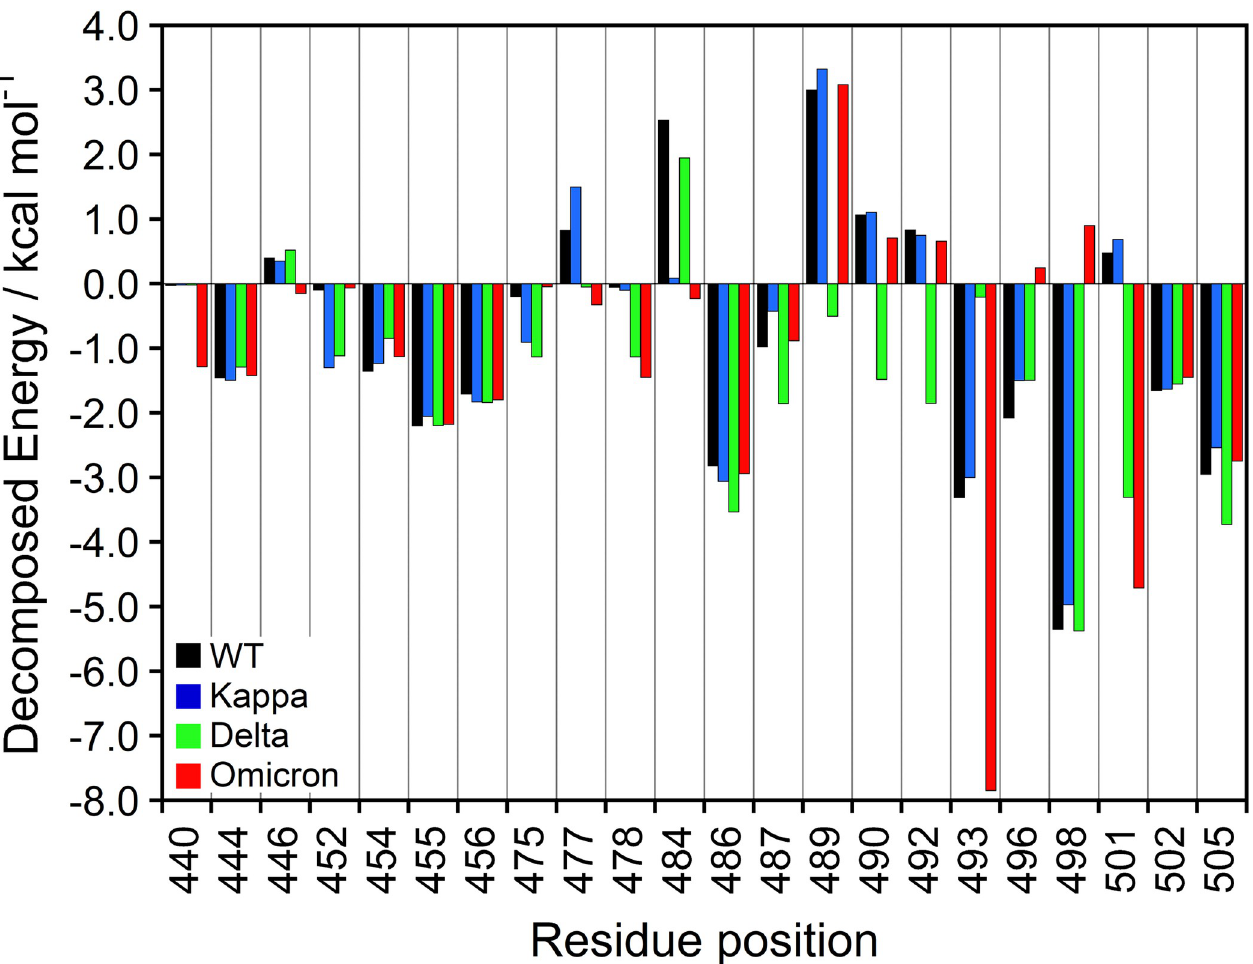
Fig 6. Per-residue free energy decomposition of the key hotspot at the S-RBD domain (residues 438–505) of the binding interface with ACE2 protein. All values were given in kcal mol -1 .